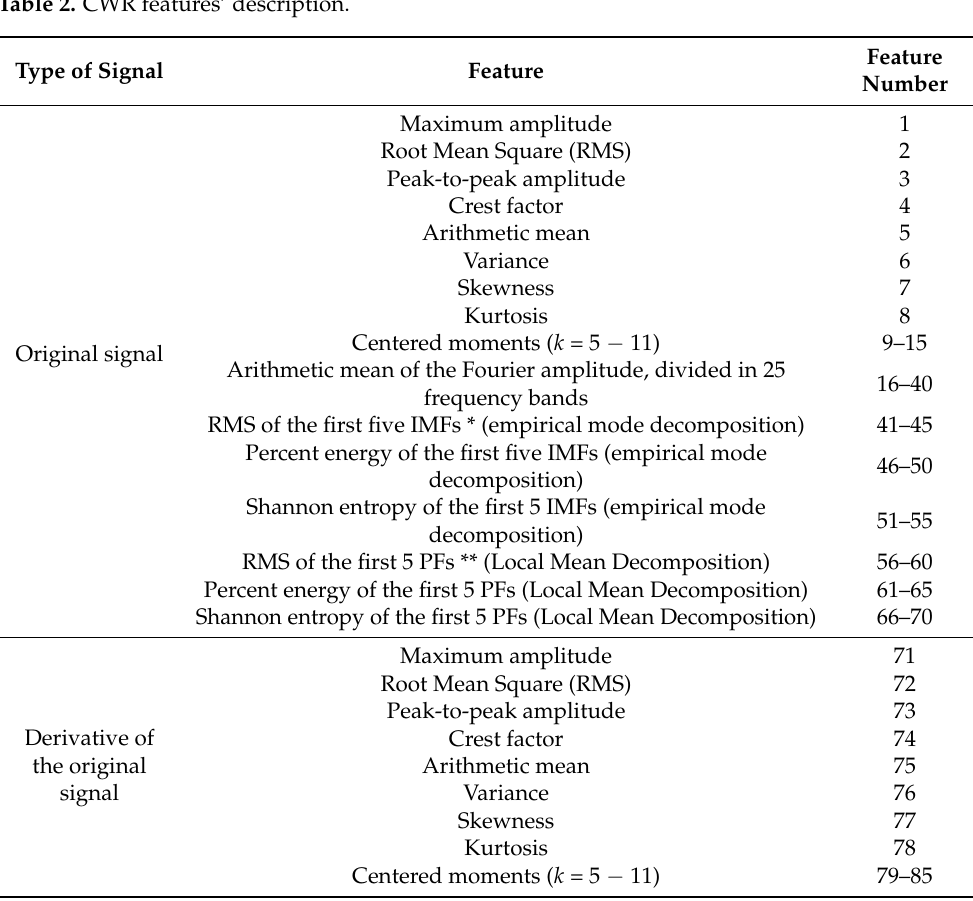
Table 2. CWR features’